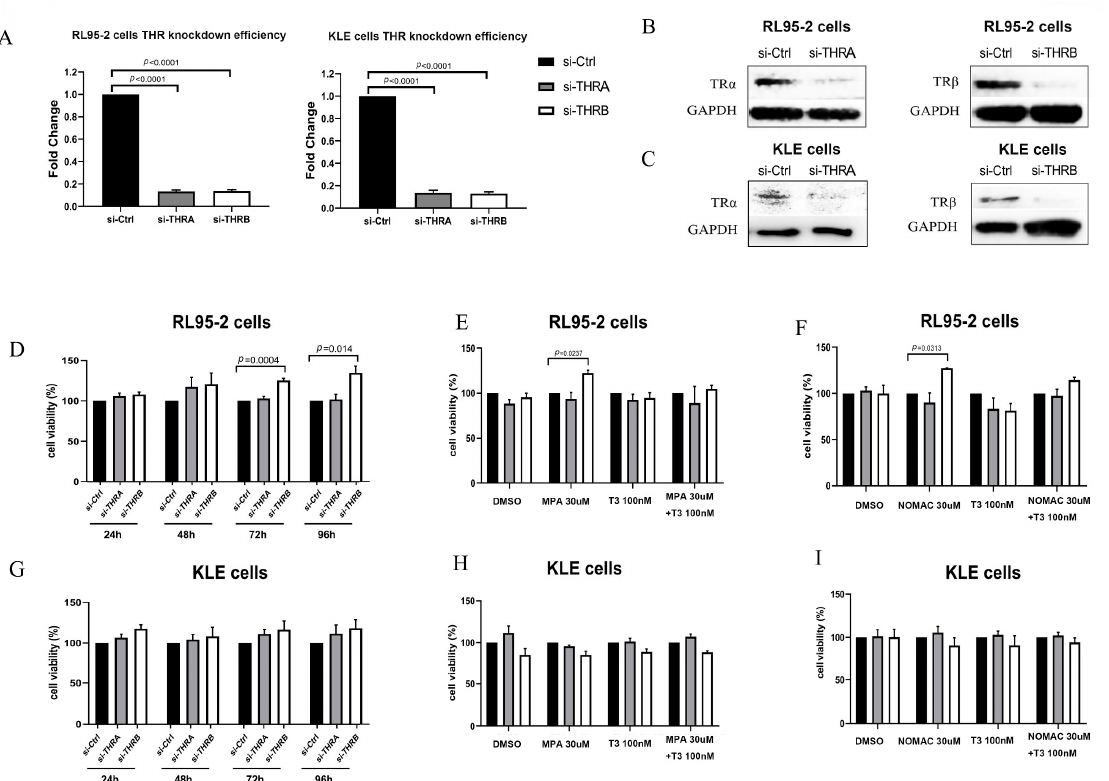
Figure 3. Progestins enhanced the growth of THRB-silenced EC cells. ( A ) THRA or THRB silencing efficiency in RL95-2 and KLE cells. ( B , C ) Protein expression of TR α or TR β silencing in RL95-2 and KLE cells. ( D , G ) Cell viability after silencing THRA or THRB in RL95-2 and KLE cells. The cells were treated with si-THRA or si-THRB for 48 h and then cultured in fresh media for 24, 48, 72, and 96 h. ( E , F ) RL95-2 or ( H , I ) KLE cells were pretreated with si-THRA or si-THRB for 48 h and then treated with 30 µ M MPA ( E , H ) or NOMAc ( F , I ); meanwhile, 100 nM T3 was added for 48 h to examine cell viability. The cell viability was normalized to the control, which was set at 100%. The results are presented as mean ± SEM of three independent experiments. TR α /THRA, thyroid hormone receptor alpha; TR β /THRB: thyroid hormone receptor beta; si-Ctrl, negative control treated with siRNA solvent; si-THRA, silenced THRA; si-THRB, silenced